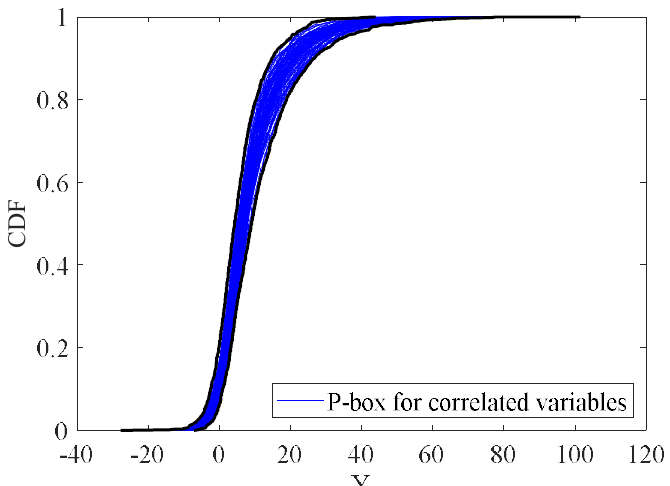
Figure 9. The initial p−box for the system analytical function with correlated variables.